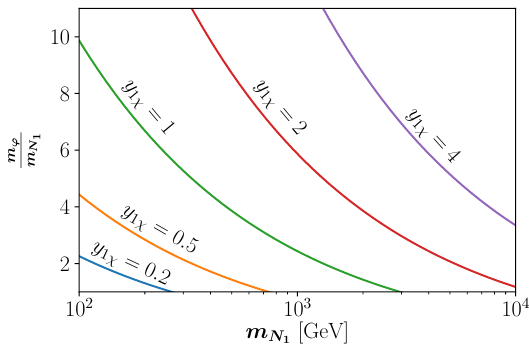
Figure 4 . Fermionic Dark Matter Scenario. E(cid:11)ective coupling y 1 (cid:31) needed in order to generate the observed relic abundance via the WIMP mechanism, assuming m ’